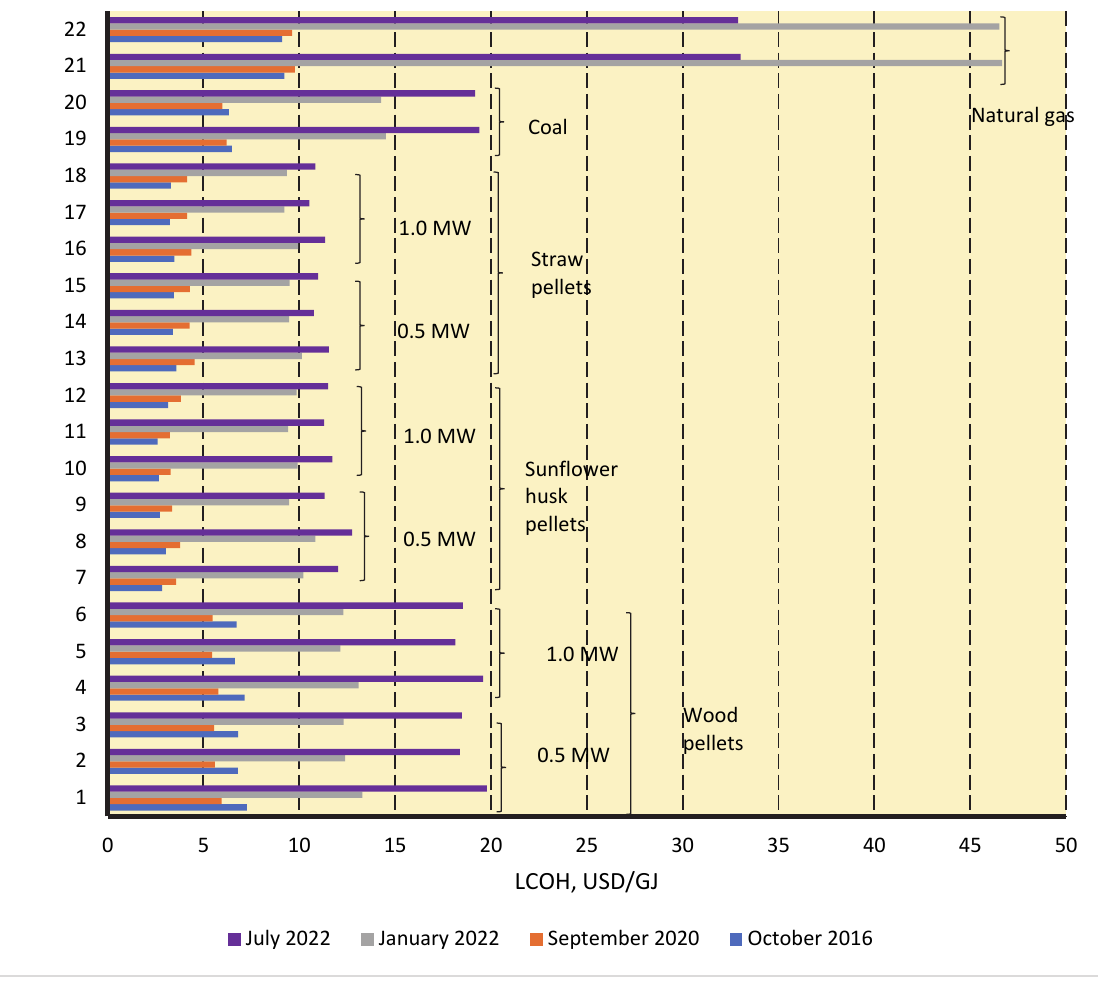
Figure 1. The evolution of LCOH (the number on the x -axis corresponds to the first column in Table 4). We found that, in Ukraine, the LCOH of biomass-fired boilers ranged from EUR 35.2/MWh to EUR 56.3/MWh. These values were lower than the LCOH for natural gas-fired boilers (EUR 100.2/MWh). This ratio is consistent with European countries. For instance, Ruffino et al. [45] reported that, in Italy, the LCOH of biomass-fired boilers is lower than the LCOH of fossil fuels. Its value ranges from EUR 72.1/MWh to EUR 118.7/MWh. In France, the situation is the same. The LCOH is around EUR 87/MWh [92]. In Poland and Switzerland, the LCOH is somewhat higher [93,94]. The attractiveness of alternative fuels is determined by the ratio of their prices to traditional fuels